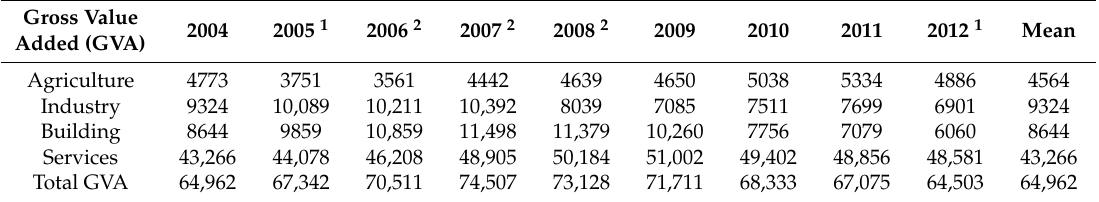
Table 4. Gross Value Added for water abstracting sectors in the Guadalquivir River Basin 2004–2012 (in million 2012 EUR).